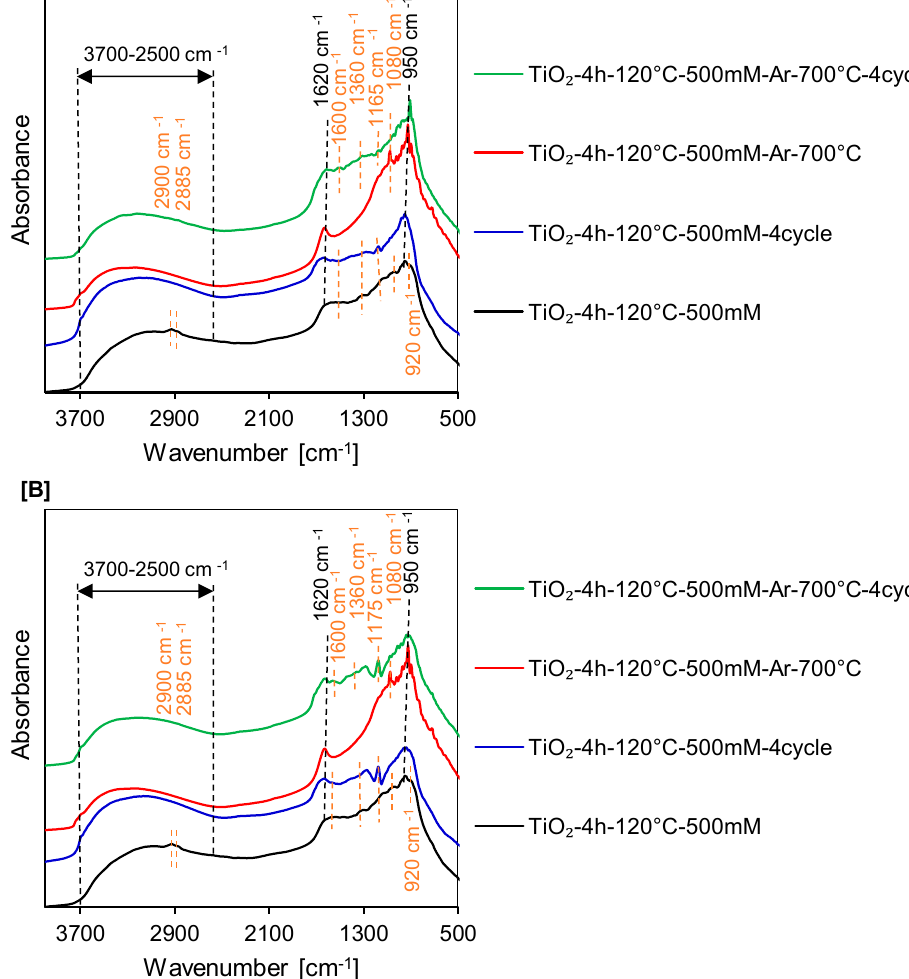
Figure 13. DRIFT spectra of TiO 2 –4h–120 ◦ C–50 mM and TiO 2 –4h–120 ◦ C–500mM-Ar–700 ◦ C photo- catalysts before the first cycle and after the fourth cycle for methylene blue ( A ), and Orange II ( B ) decomposition.